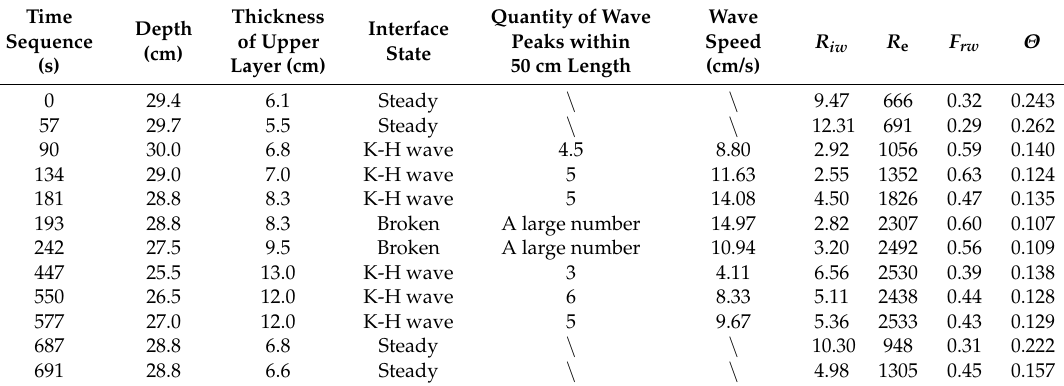
Table 3. The characteristic parameters at the 25 m section of the flume.